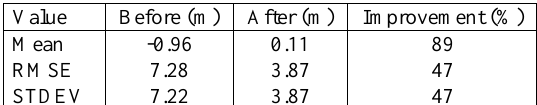
Table 2. Height difference values for area #1 before and after morphing, with triangle threshold.